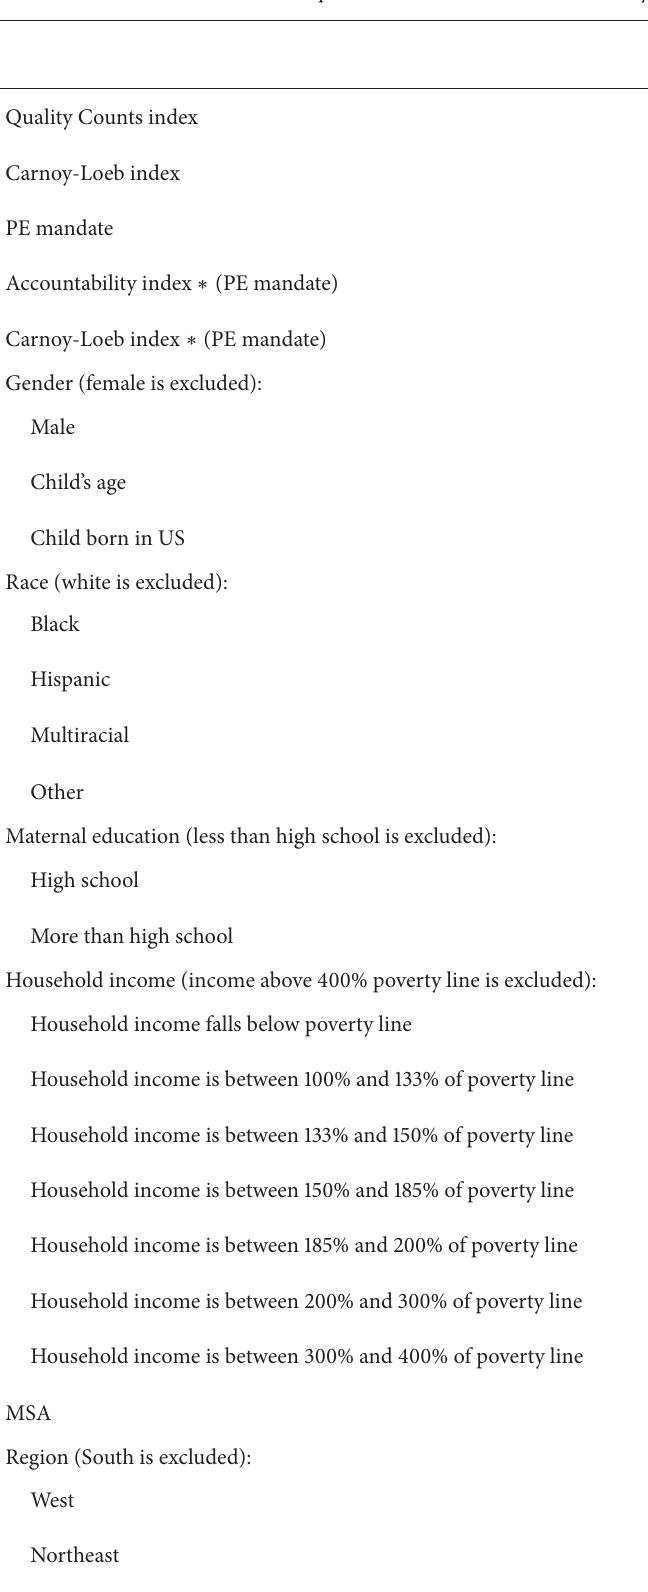
Table 4: Empirical results: effect of accountability pressures on overweight levels, grades